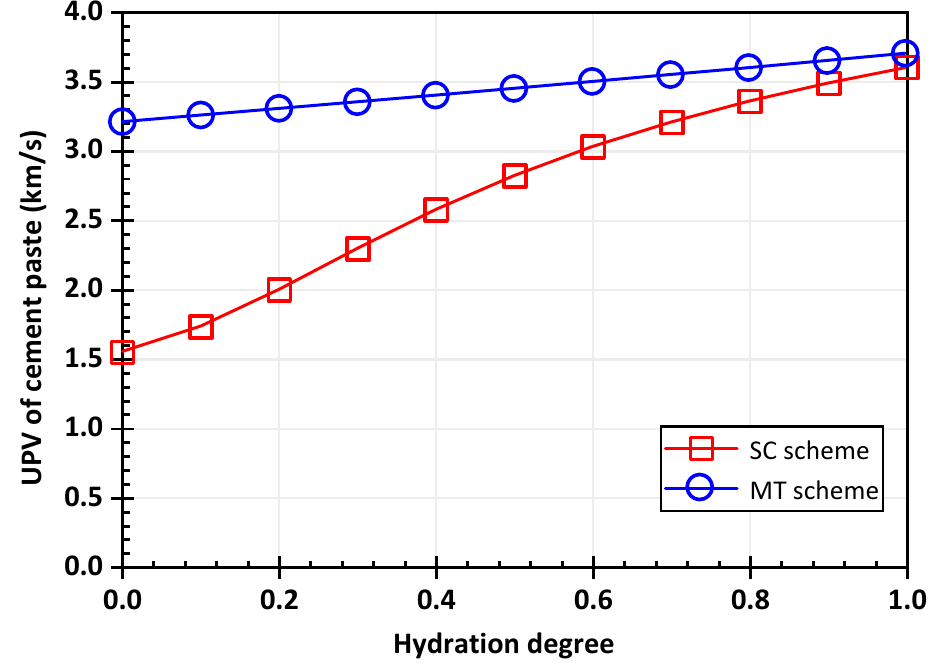
Figure 5. The ultrasonic pulse velocity prediction based on the different schemes.